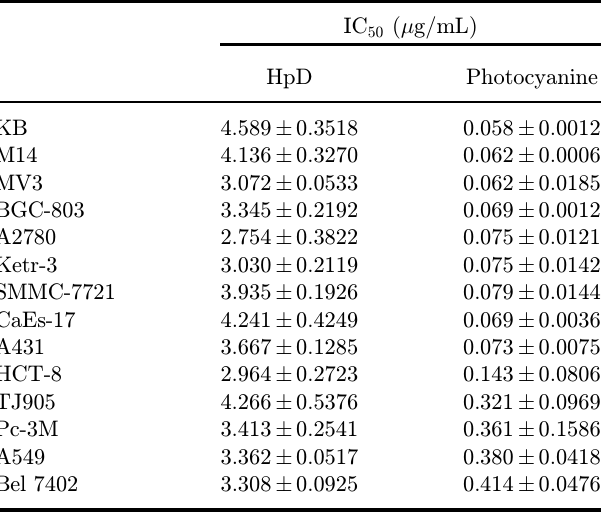
Table 1. In vitro photodynamic activity of Photocyanine against various tumor cells compared with